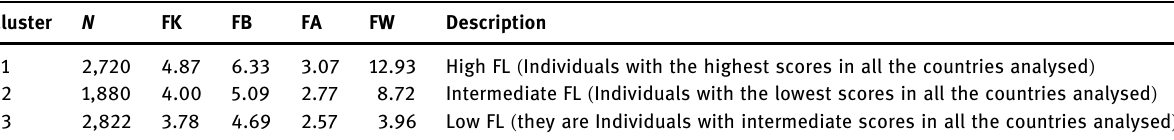
Table 12: Variables means for the three clusters ( C1, C2, and C3 )